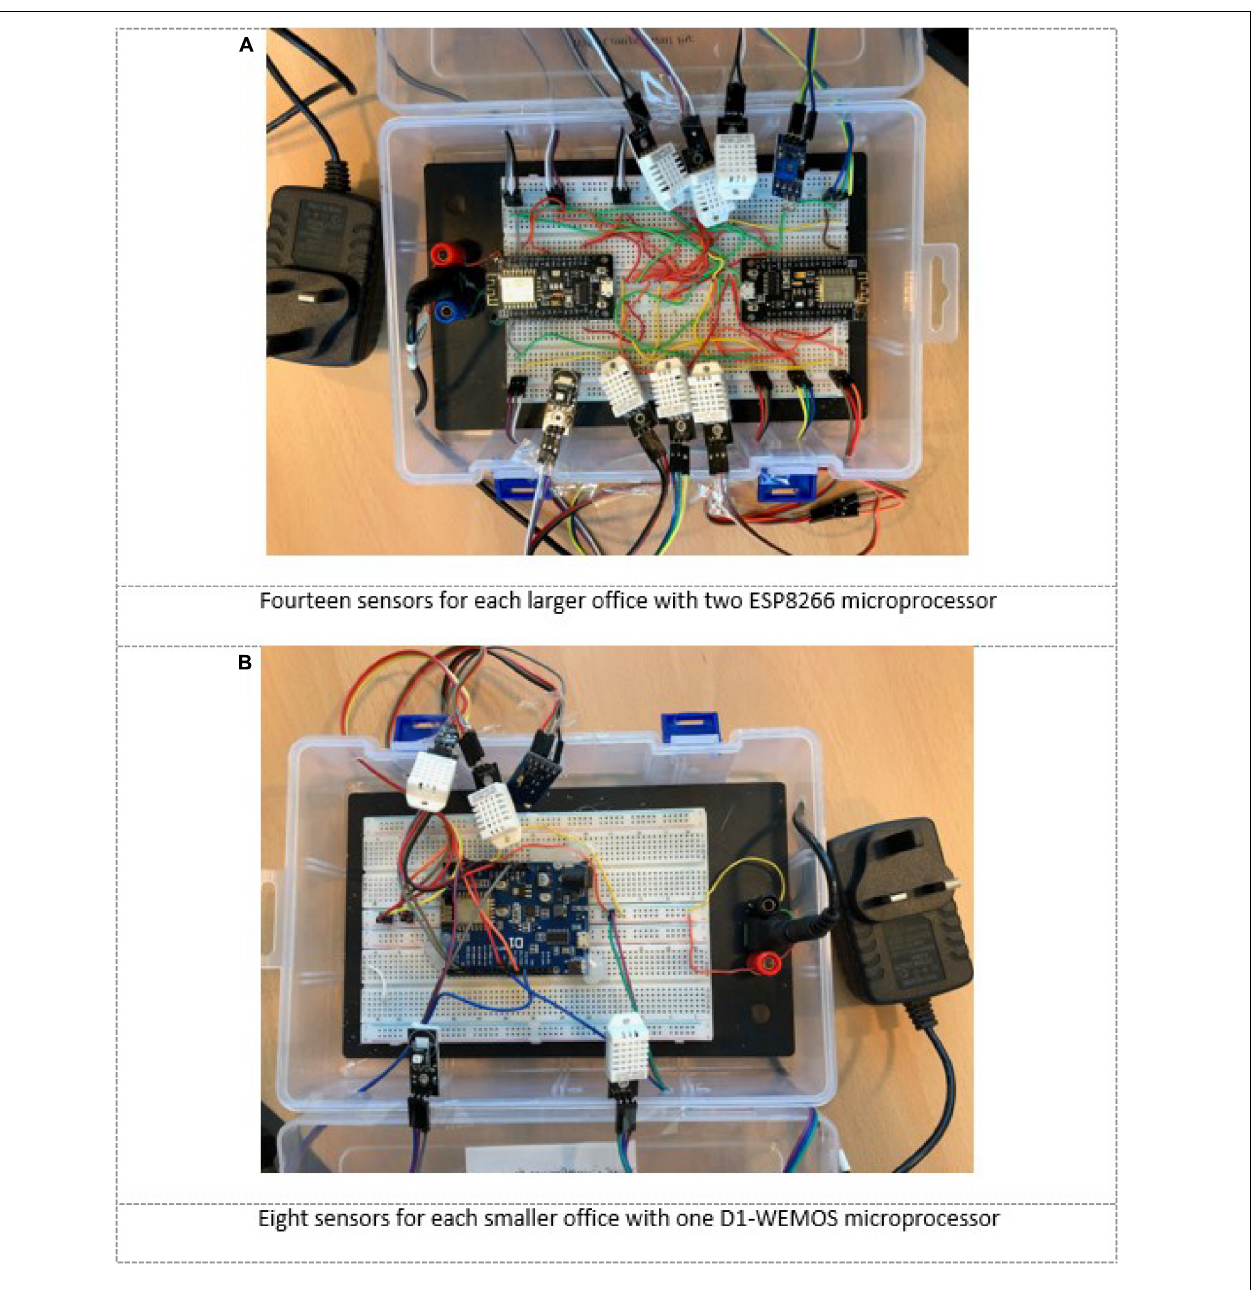
FIGURE 5 | Assembled boards with ESP8266 and D1-WEMOS Arduino microprocessors and DHT22, LUX, and UV sensors. (A) Data logger in large offices. (B) Data logger in small offices.